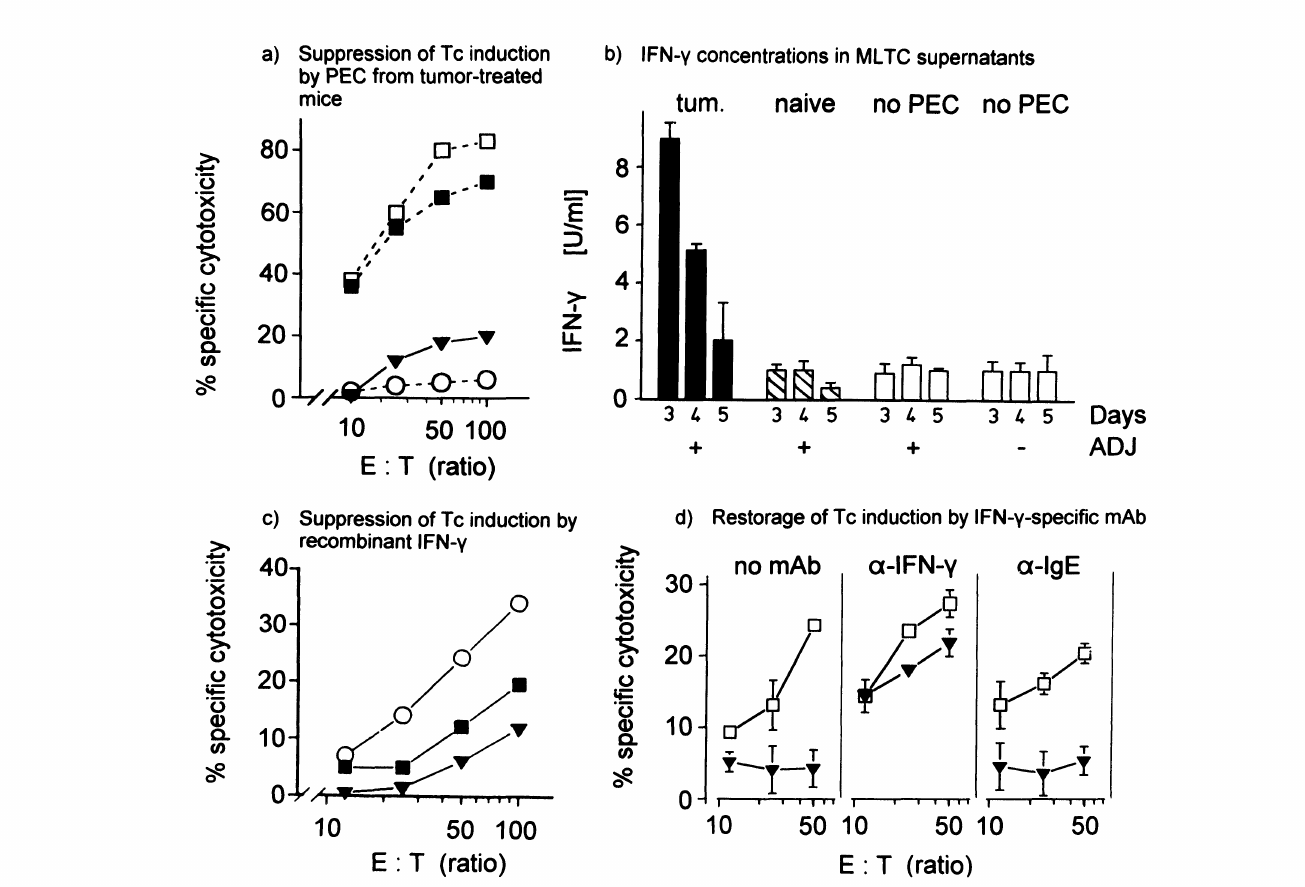
Suppression by PEC from ADJ-PC-5-treated mice is due to IFN-y. (a) Suppressive T cells were generated by repeated i.p. injections of exponentially increasing numbers of X-irradiated ADJ-PC-5 cells (according to Materials and Methods) and added to an ADJ- PC-5-specifi MLTC on day 0. The resulting tumor-specific cytotoxicity was measured on day 6 by a 51Cr-release assay. The cytotoxicity in the presence of nonadherent PEC from tumor treated mice (’--’) was compared with the cytotoxicity in the presence of PEC from naive mice (I--I). Control cultures were set up without PEC (Fq--[3) or without PEC and ADJ-PC-5 cells (C)--(C)). (b) Cytokine kinetics in MLTC supernatants corresponding to part (a). Substantial amounts of IFN-y can only be detected in MLTC supernatants containing suppressive T cells from tumor-treated mice (tum.). Samples of culture supernatants were taken at the indicated time points and assaged for IFN-T according to Materials and Methods. (c) MLTC cultures were set up with 2 107 navie BALB/c spleen cells and 106 X-irradiated ’ ADJ-PC-5 cells in the presence of different concentrations IFN-y: O: no IFN-y added; I: 50 U/ml; and 500 U/ml. Specific cytotoxicity was measured on day 6 of the culture period. (d) MLTC cultures were set up with (’--’) or without (F-l--E]) nonadherent PEC from tumor- treated mice in the presence of. 20 txg/ml of an IFN-y-specific monoclonal rat IgG antibody (ce-IFN-y) or in the presence of 20 tzg/ml of an irrelevant IgE-specific rat IgG monoclonal antibody